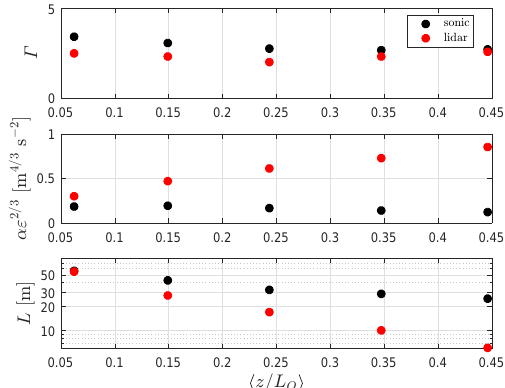
Figure 18. Mann parameters for a number of atmospheric-stability conditions (see Table 1) derived from sonic anemometer and lidar radial velocity